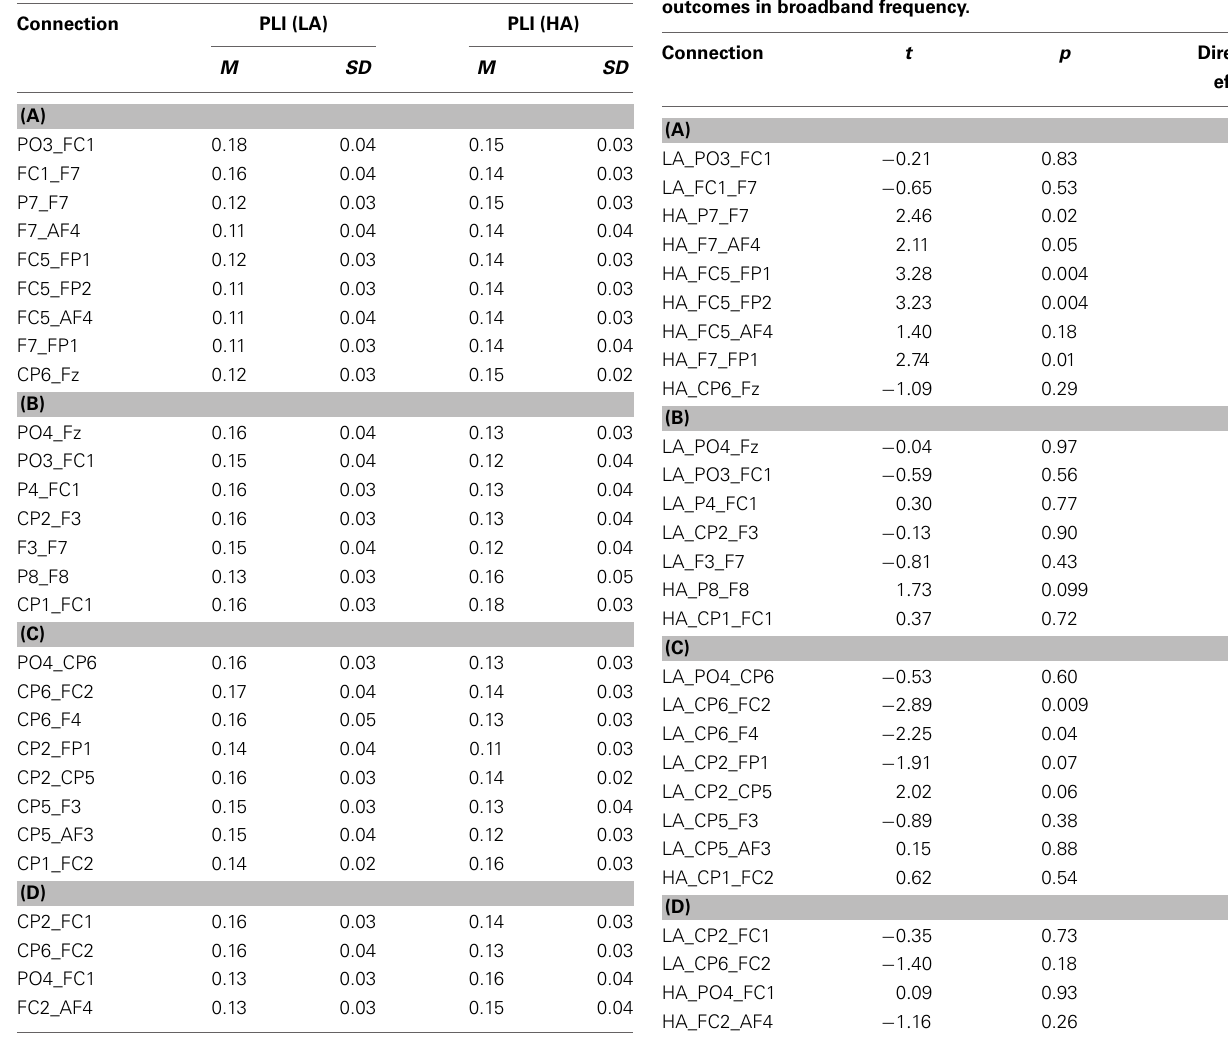
Table 1 | Mean PLI during high (HA) and low experiences of agency (LA) in trials in which (A) goals matched the outcomes, (B) goals mismatched the outcomes, (C) primes matched the outcomes, and (D) primes mismatched the outcomes in broadband frequency.